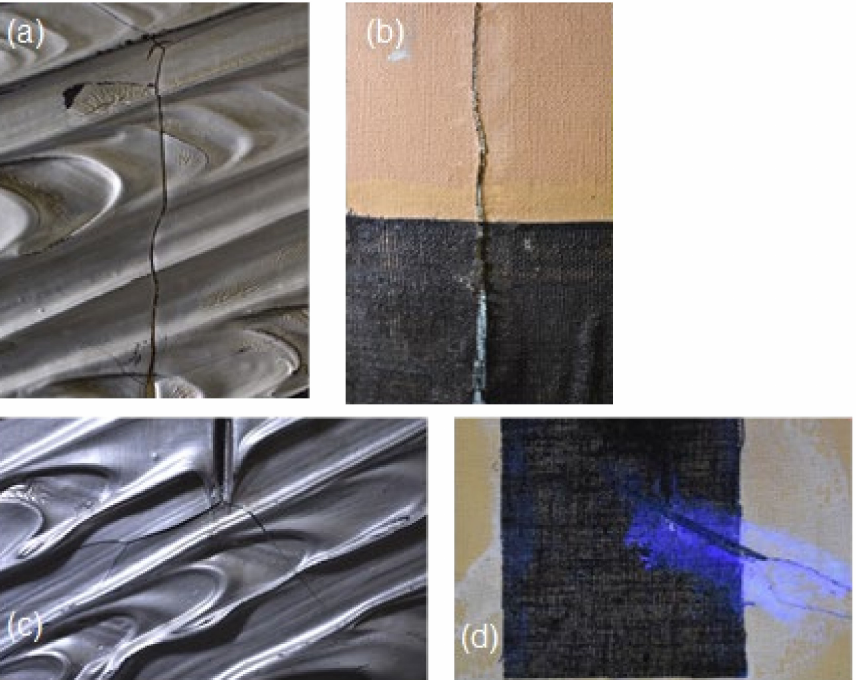
Figure 1. Some details of alterations observed in the monochrome silver “Concetto spaziale” by Lucio Fontana: ( a ) crack developed from the upper end of the cut; ( b ) tear in the original canvas and “teletta”; ( c ) degradation of the pictorial material; ( d ) old restoration in the lower area of the cut, with presence of a textile patch, observed under UV